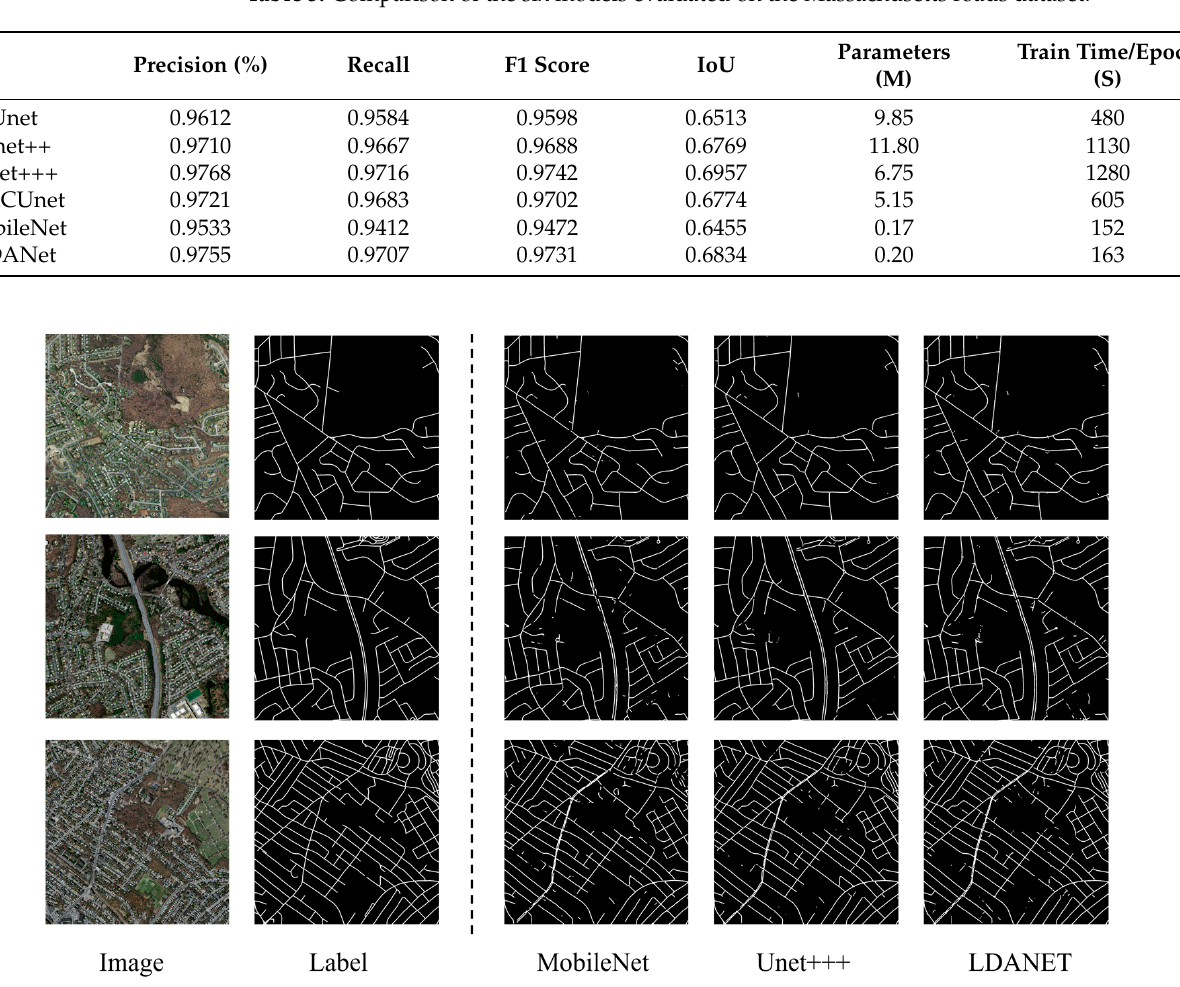
Figure 7. LDANet extraction results on the Massachusetts roads dataset.